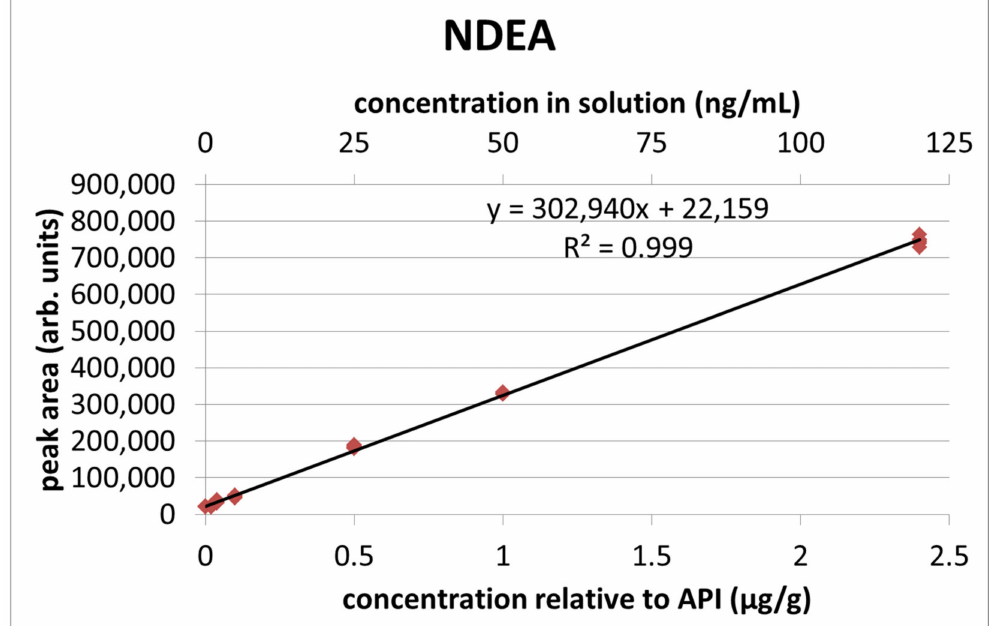
Figure 8. Calibration curve for NDEA. The upper x -scale expresses the concentrations in the solution in ng/mL, and the lower x -scale shows the concentration in relation to the API, expressed in µ